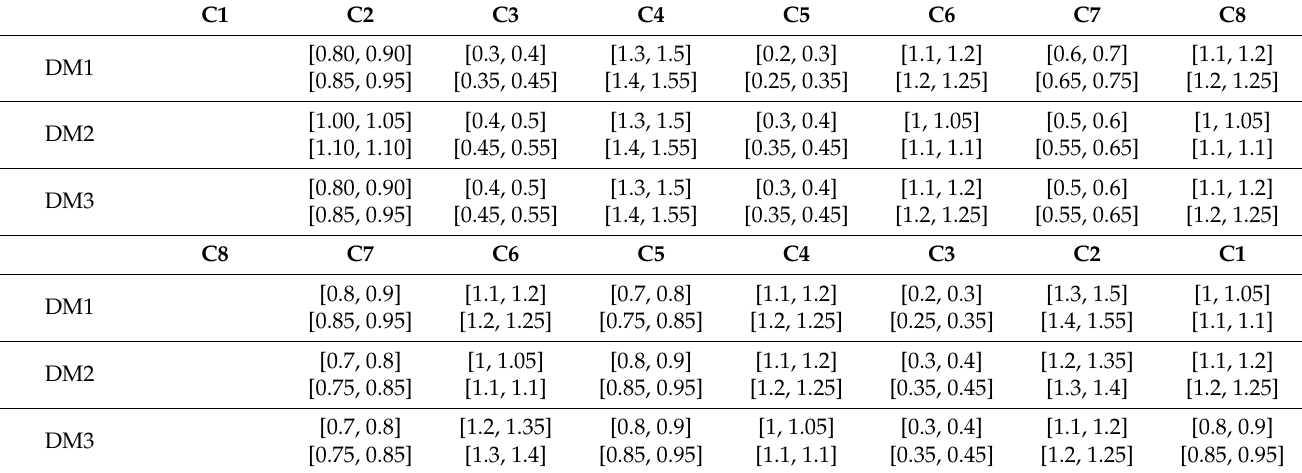
Table 4. Assessment of criteria by three